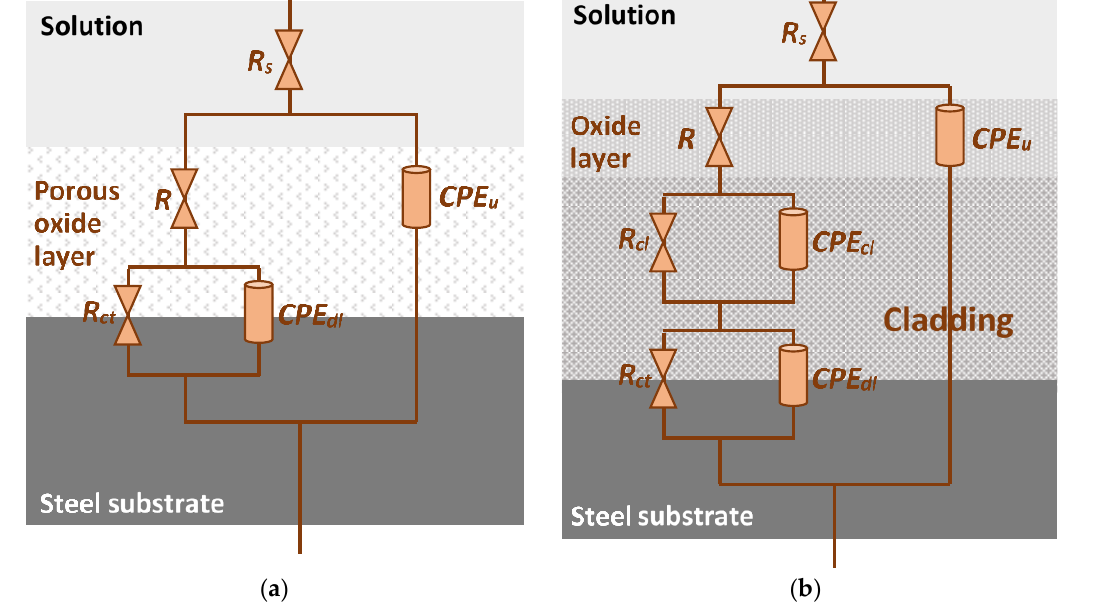
Figure 9. Equivalent circuits used for fitting the EIS data of the ( a ) bare steel and ( b ) cladded samples after 21-day immersion. Table 4. EIS parameters for the bare steel, unprocessed Al and cladded samples after 21-day immersion in 3.5% NaCl